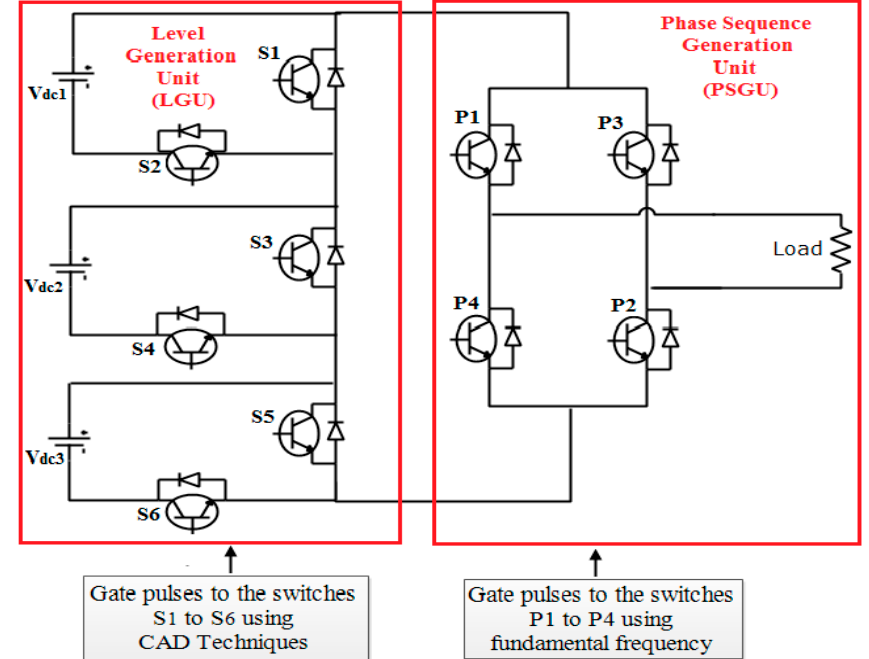
Figure 7. Single-phase seven-level DCLCHB inverter.